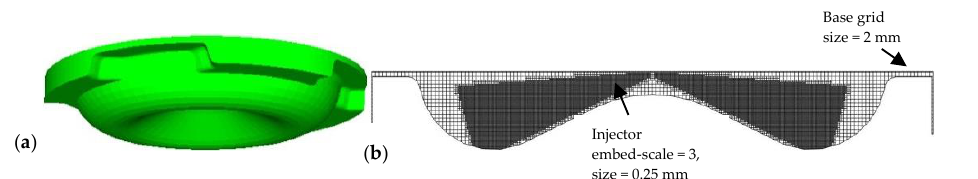
Figure 2. Illustration of geometry and the computational mesh at TDC: ( a ) Geometry of engine for modelling; ( b ) illustration of computational mesh at TDC. (Amr-velocity (1 m/s), scale = 3, and size = 0.25 mm; Amr-temperature (2.5 K), scale = 3, and size = 0.25 mm).